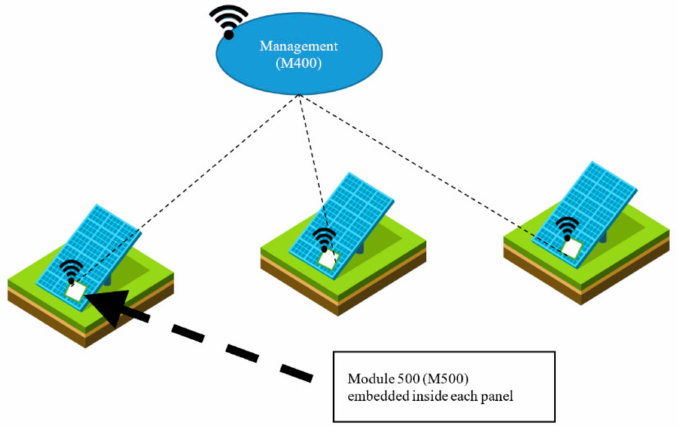
Figure 6. Daedalus: Distributed energy resource asset management system.